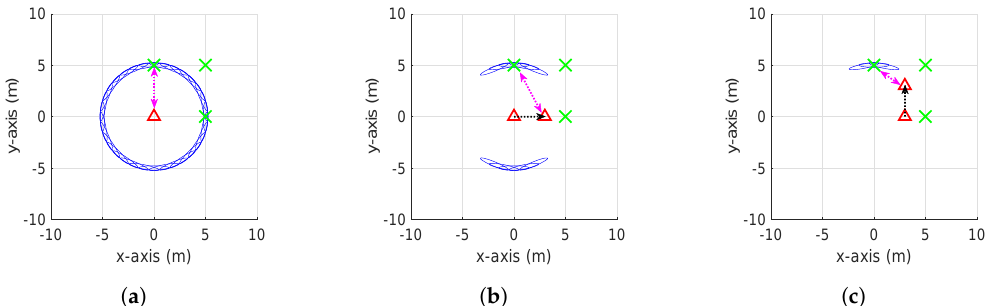
Figure 1. Explanation of the conventional RO-SLAM algorithms. Red triangles and green crosses indicate robots and neighbor nodes, respectively. Black and magenta dotted lines are the movement of the robot and range measurements, respectively. Blue ellipse is a possible location of